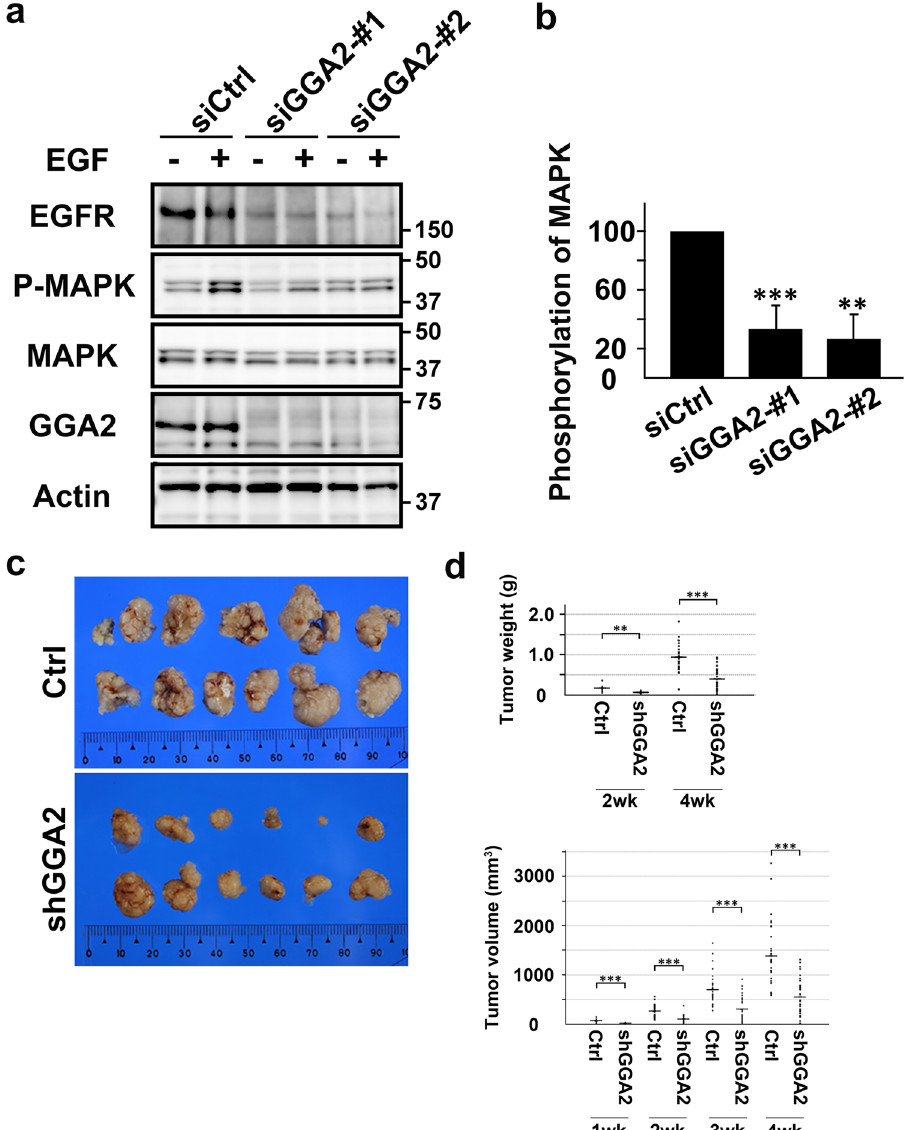
Figure 6. EGF-induced EGFR signaling and cell growth are impaired in GGA2-depleted cells. ( a ) Control (siCtrl) and GGA2-depleted (siGGA2-#1 and siGGA2-#2) ARPE-19 cells were treated with ( + ) or without ( − ) 10 nM EGF for 5 min and were then lysed for western blot analyses with antibodies against EGFR, phosphorylated MAPK (P-MAPK), MAPK, GGA2, or tubulin. Uncropped blots are presented in Supplementary Fig. 7. ( b ) Increase in the ratio of P-MAPK to MAPK after EGF stimulation was calculated and normalized to the value of siCtrl. Mean ( ± SD) of three experiments were plotted. Statistical difference between the control and each GGA2 siRNA was identified using Student’s t -test ( ** P < 0.01 and *** P < 0.001). ( c ) Control (Ctrl) or GGA2-depleted (shGGA2) LoVo cells were transplanted into nude mice. Tumors were excised at 4 weeks after transplantation. ( d ) Tumor weights and volumes were measured at the indicated time points and displayed as dot plots (mean [horizontal bar] ± SD). Statistical analyses were performed using Mann-Whitney U -test; *** P <